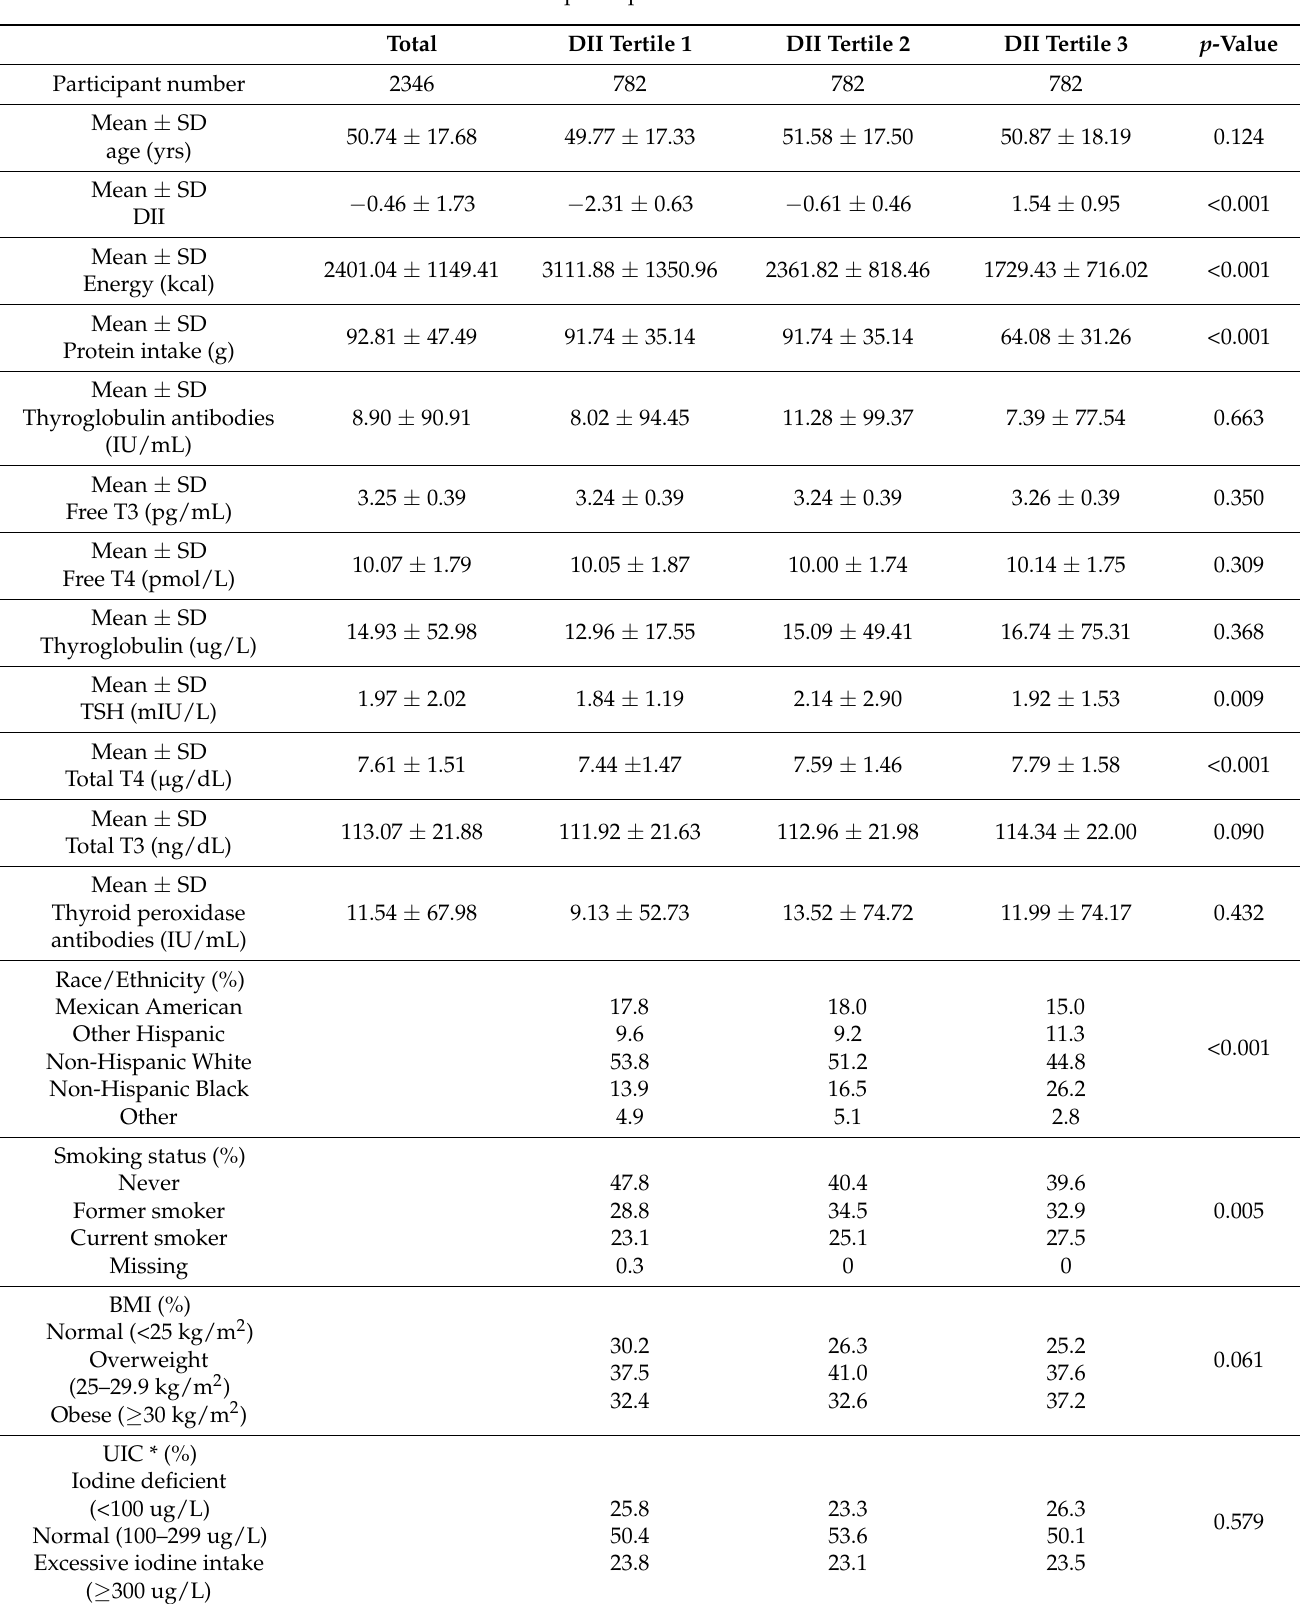
Table 1. Baseline characteristics of participants in the 2007–2008 continuous